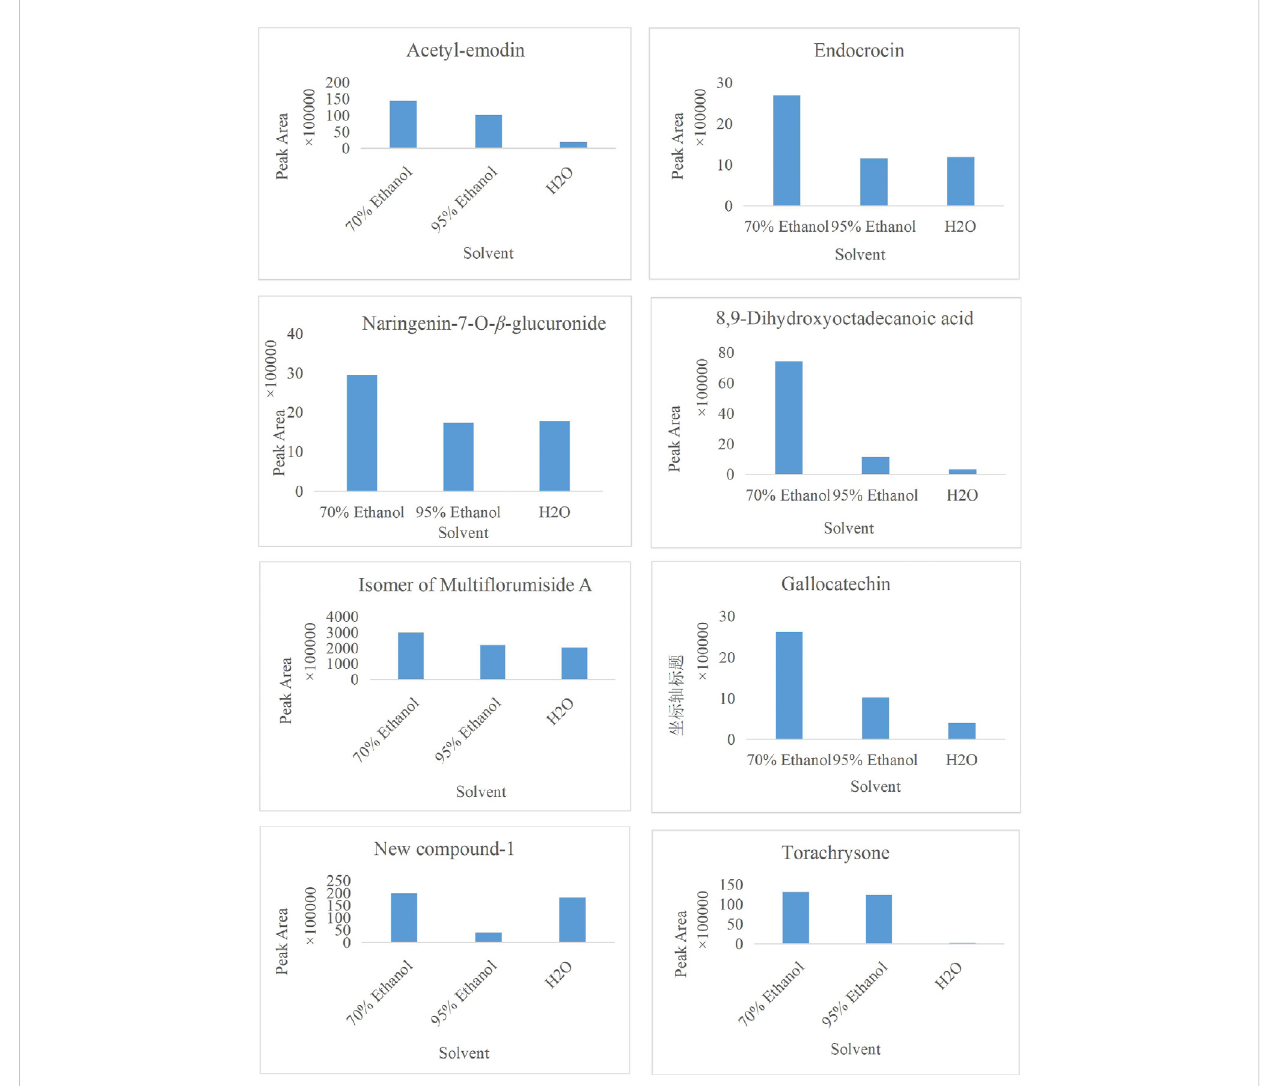
FIGURE 15 Histogram of peak area of compound acetyl-emodin, endocrocin, naringenin-7-O- β -glucuronide, 8,9-dihydroxyoctadecanoic acid, the isomer of multi fl orumiside A, gallocatechin, new compound-1, and torachrysone in three solvents.